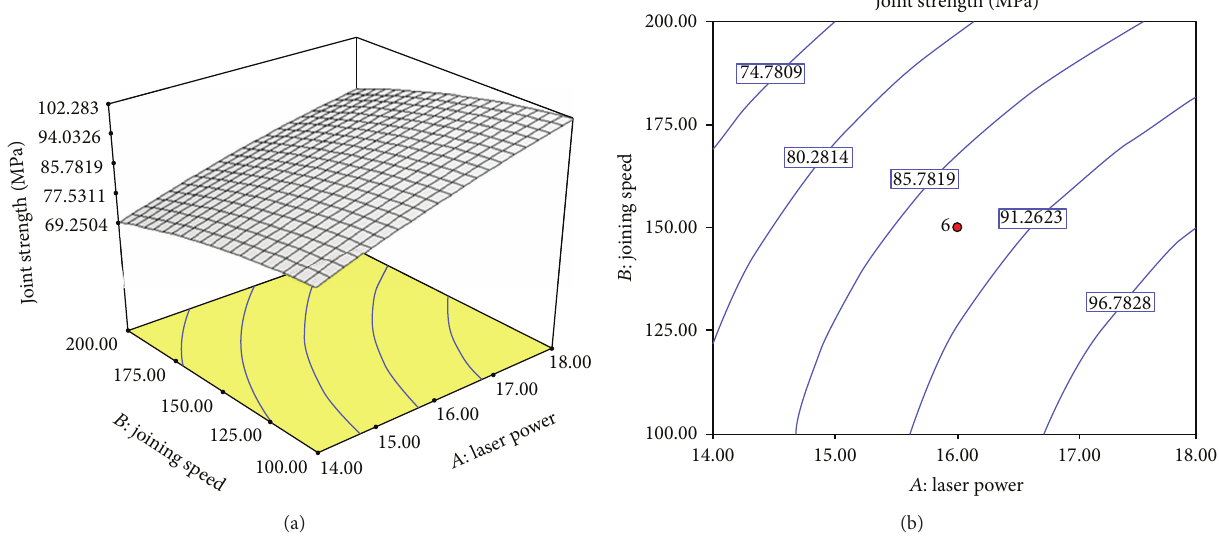
Figure 8: Interaction effect of laser power and joining speed on the joint strength. (a) 3D interaction; (b) the contour plot.